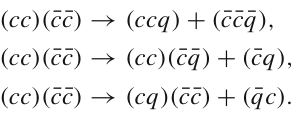
Fig. 4 Poles motion as the coupling g f increases starting from zero: the filled circles represent the positions of the bare poles (for g f = 0), the arrows show the direction of motion as g f increases, and the cross represents the physical pole of the X ( 6200 ) . The left plot corresponds to the case γ V > 0 (bound state generated by the potential V ( p , p (cid:2) ) from Eq. (27)) and the right plot is for γ V < 0 (virtual state generated by V ( p , p (cid:2) )